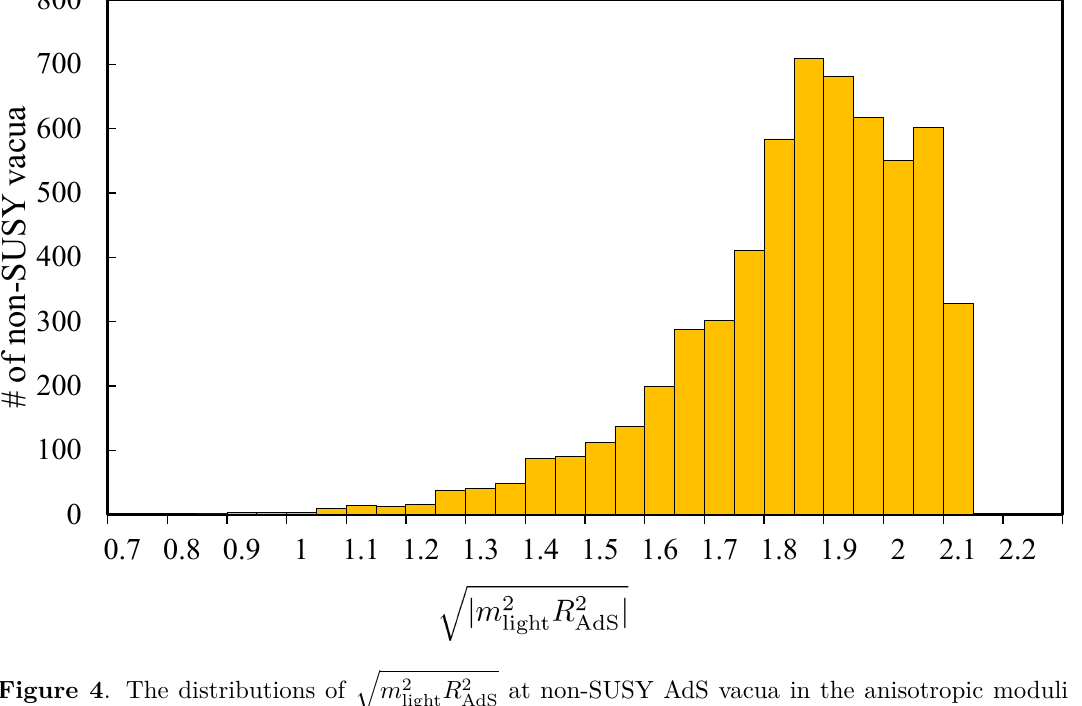
Figure 3 . The distributions of All vacua here satisfy the BF bound.